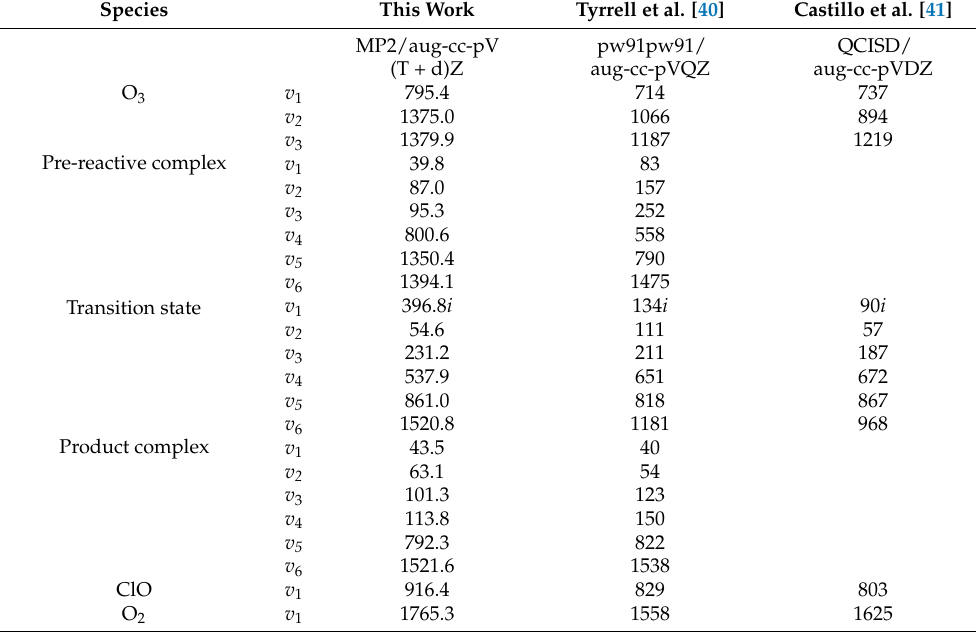
Table 2. Vibrational frequencies (cm − 1 ) for the reaction of Cl + O 3 at various levels of theory. Species This